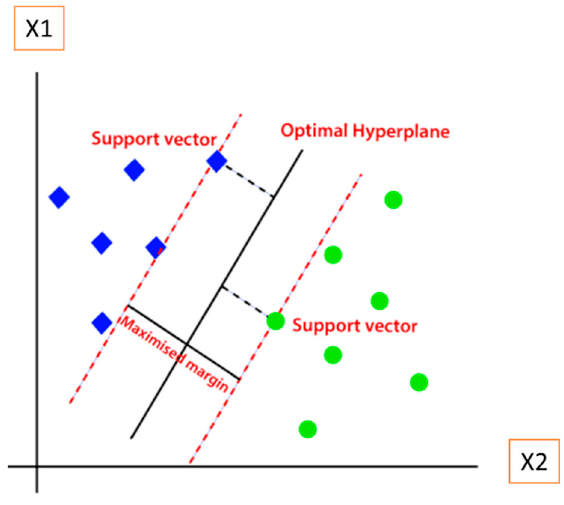
Figure 3. The components of SVM [17].